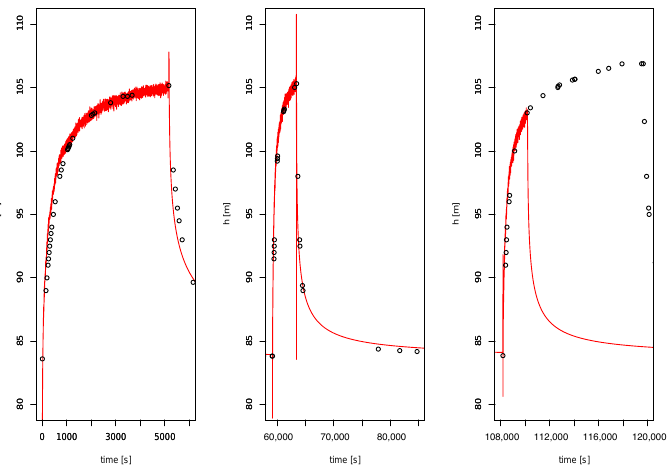
Figure 12. Validation. 2nd set of parameters. Water level evolution.